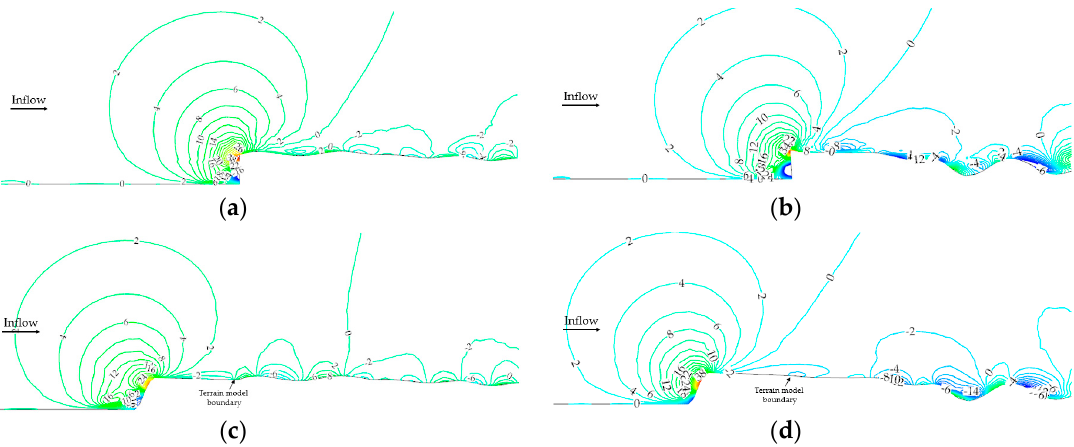
Figure 12. Wind attack angle distribution along the inflow direction near the inlet of the terrain model without or with improved BTS from CFD simulation (unit: °). ( a ) Case 1 without BTS; ( b ) Case 2 without BTS; ( c ) Case 1 with BTS; ( d ) Case 2 with BTS.